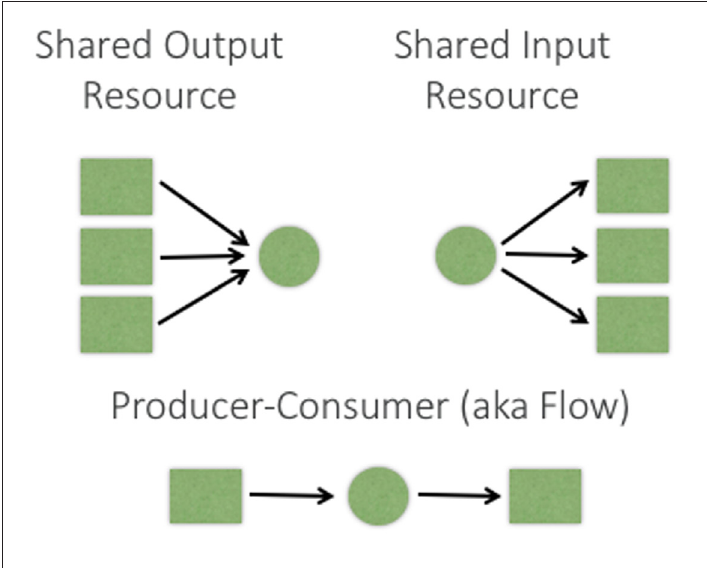
Figure 2: Three types of dependencies between two tasks (rectangles) based on shared use of resources